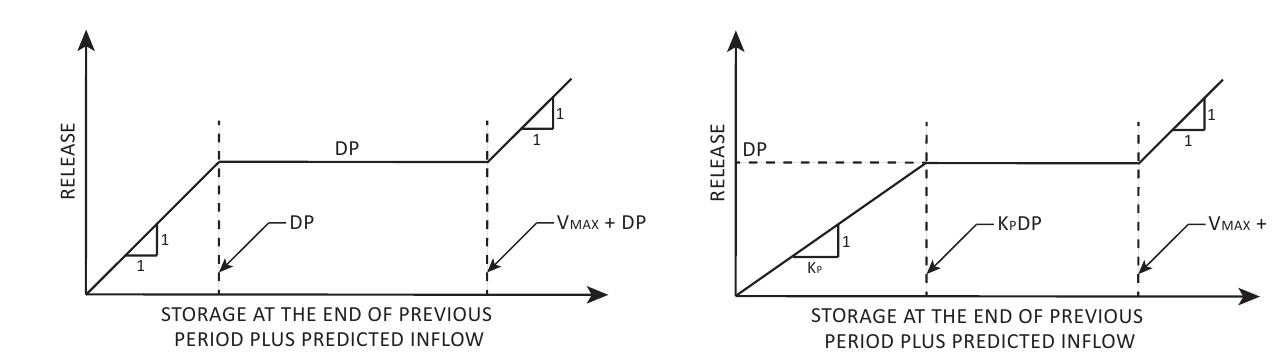
Figure 3. Hedging policy, where K P is hedging release function slope (adapted from Shih and ReVelle,